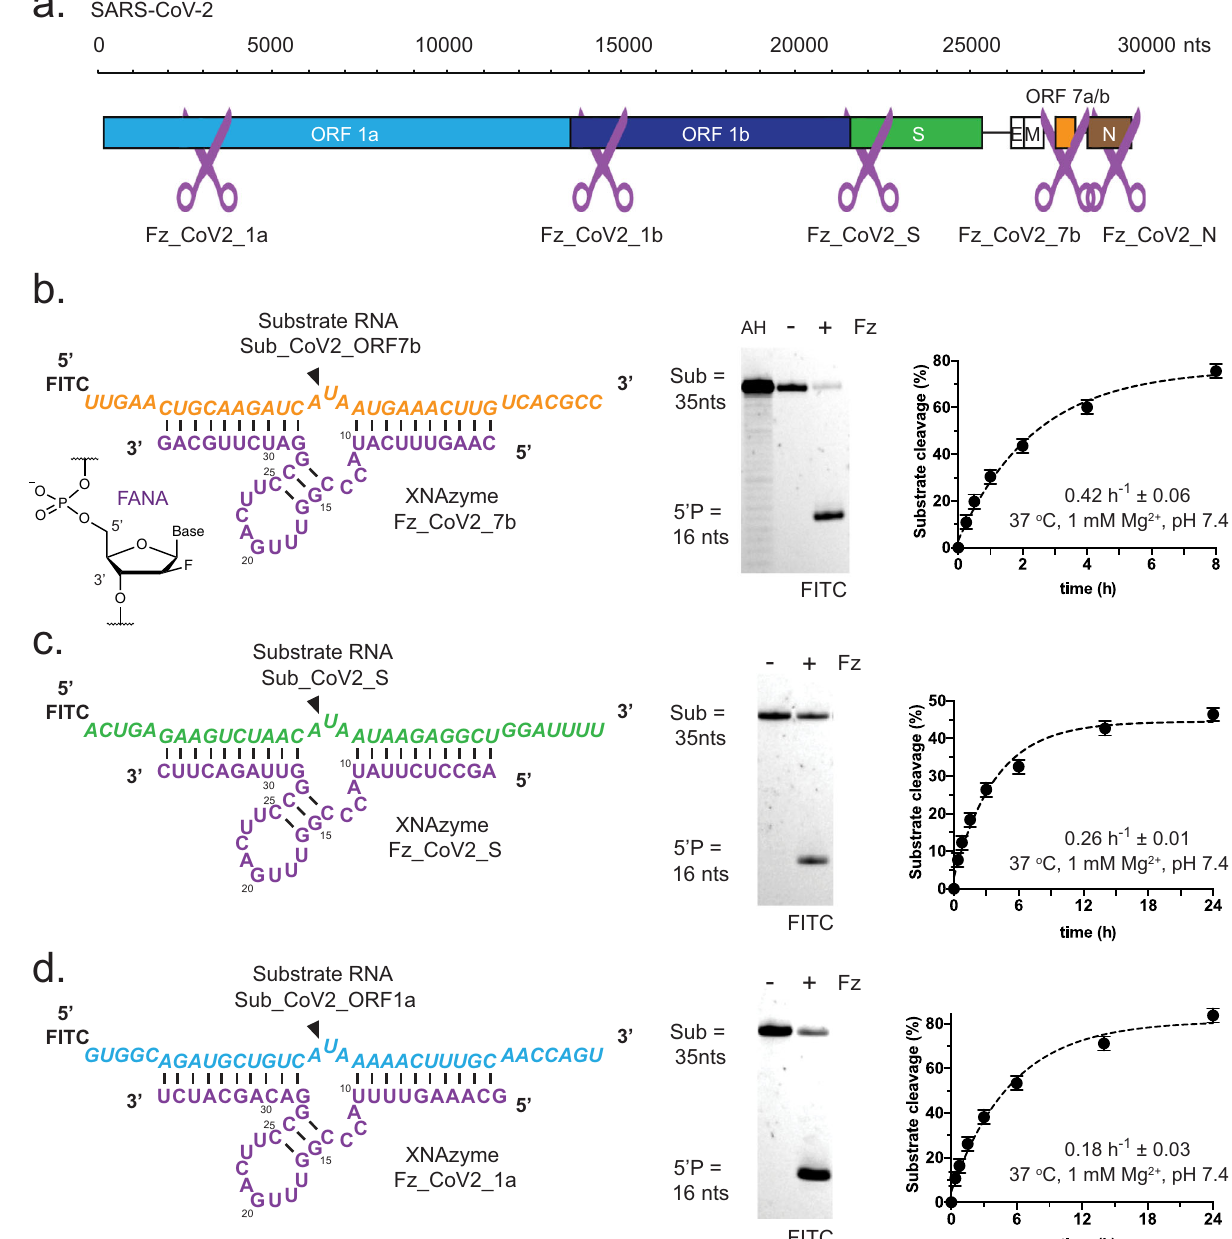
Fig. 1 | RNA endonuclease XNAzymes retargeted to the SARS-CoV-2 genome. a Schematic showing target locations in the SARS-CoV-2 RNA genome of all active XNAzymes describedinthis study (seealso Supplementary Fig. 1). b – d Schematics showing sequences and putative secondary structures of XNAzymes targeting sequences in the b ORF7b, c Spike(S),or d ORF1a genes, bound to substrate RNAs containing their SARS-CoV-2 target sequences. Purple indicates FANA residues.